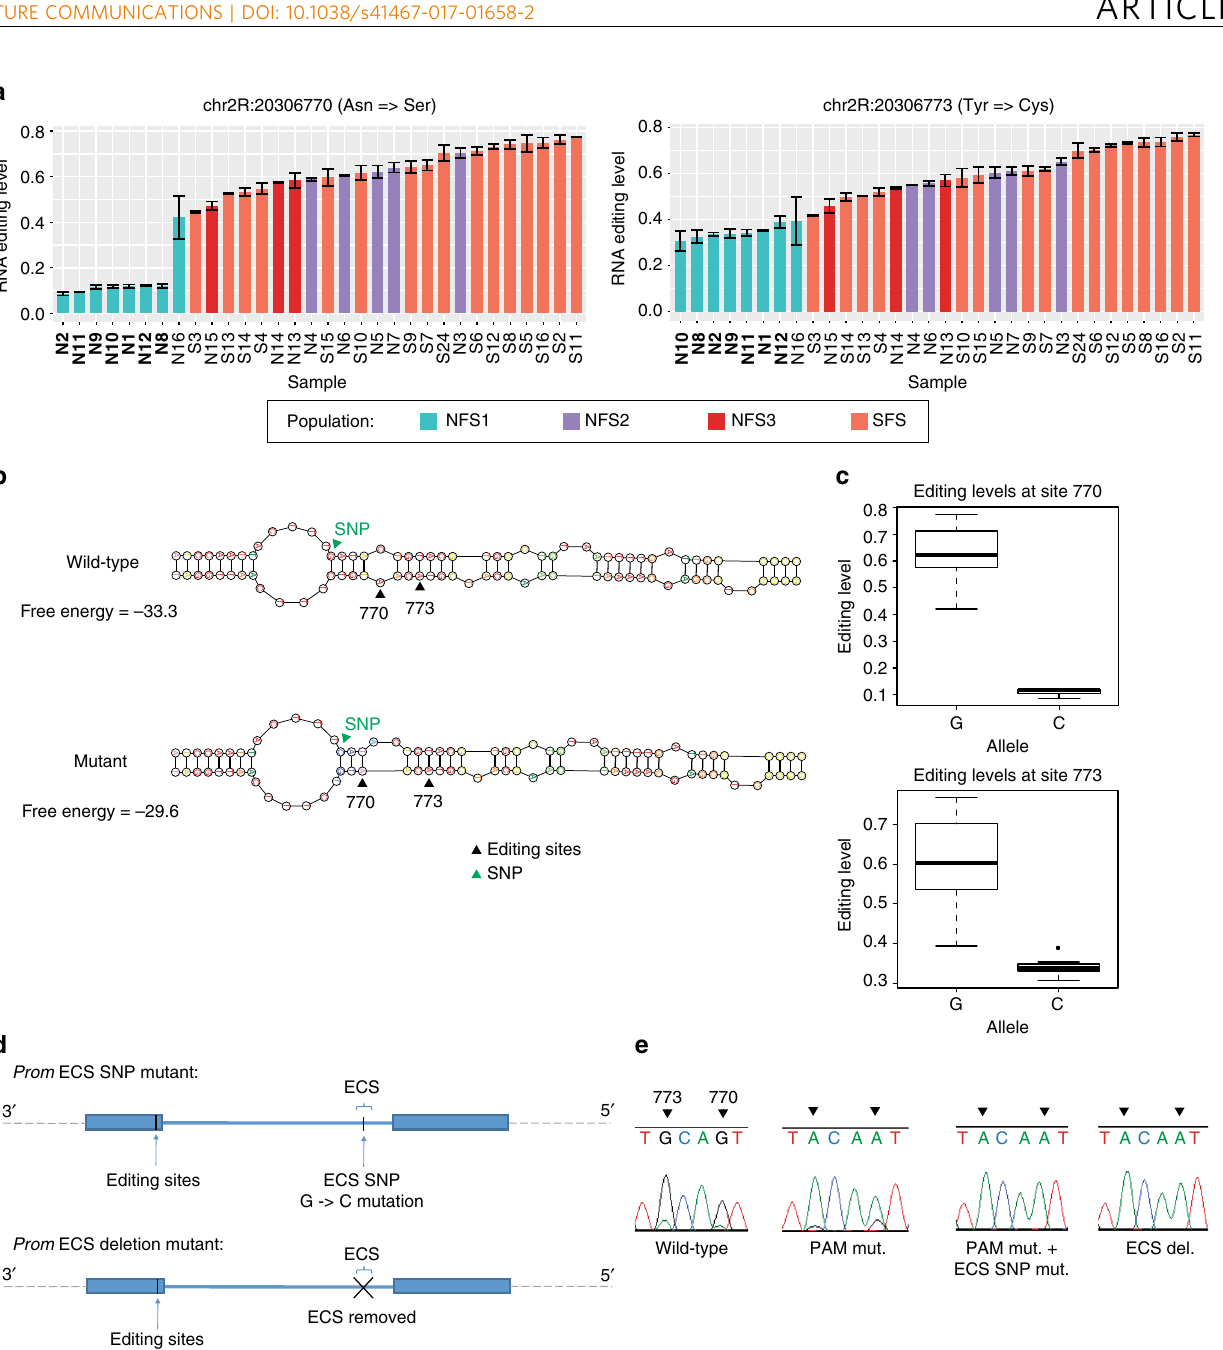
Fig. 4 An intronic SNP affects prominin editing levels. a Prominin editing levels for each of the 32 Evolution Canyon fl y lines. The editing levels for each sample represent the average editing levels of two biological replicates. The sub-populations are labeled as follows: NFS1 (turquoise), NFS2 (purple), NFS3 (red), SFS (orange). Samples in bold represent those that have the SNP that is correlated with prominin editing levels. Error bars represent standard error of the mean. b RNA structure predictions for the prominin editing sites and their corresponding ECS, for both wild-type prominin and with the SNP in the prominin ECS that is correlated with its editing levels. c Boxplot showing editing levels for prominin site 770 and site 773, for 7 Evolution Canyon fl y lines with wild-type alleles and 25 Evolution Canyon fl y lines with mutant alleles. The editing levels for both sites are represented by 7 NFS1 lines and 16 SFS lines. d Schematic showing the prominin ECS deletion and ECS SNP mutation. e Sanger sequencing traces showing prominin editing levels in whole bodies of wild-type, PAM mutant, PAM mutant with ECS SNP mutant, and ECS deletion mutant fl ies. Each trace represents editing levels from a single fl trends in editing differences among the fl y lines. Prominin is a membrane protein in photoreceptor cells that is involved with rhabdomere separation 32,33 . The two editing sites (which we will refer to as “ 770 ” and “ 773 ” based on their position in the genome) each encode a non-synonymous amino acid change (Asparagine to Serine for site 770 and Tyrosine to Cysteine for site 773), and are located in one of the extracellular domains of the protein 34,35 .